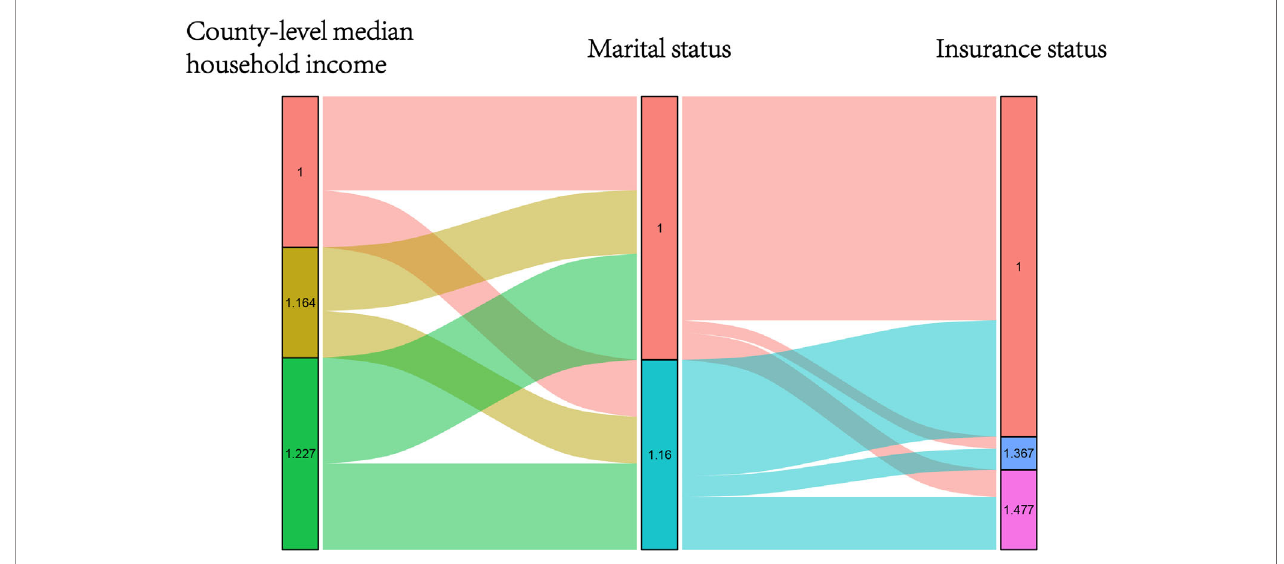
FIGURE 3 | Graphical summary of the distribution and associations of different score subgroups in county-level median household income, insurance status and marital status,